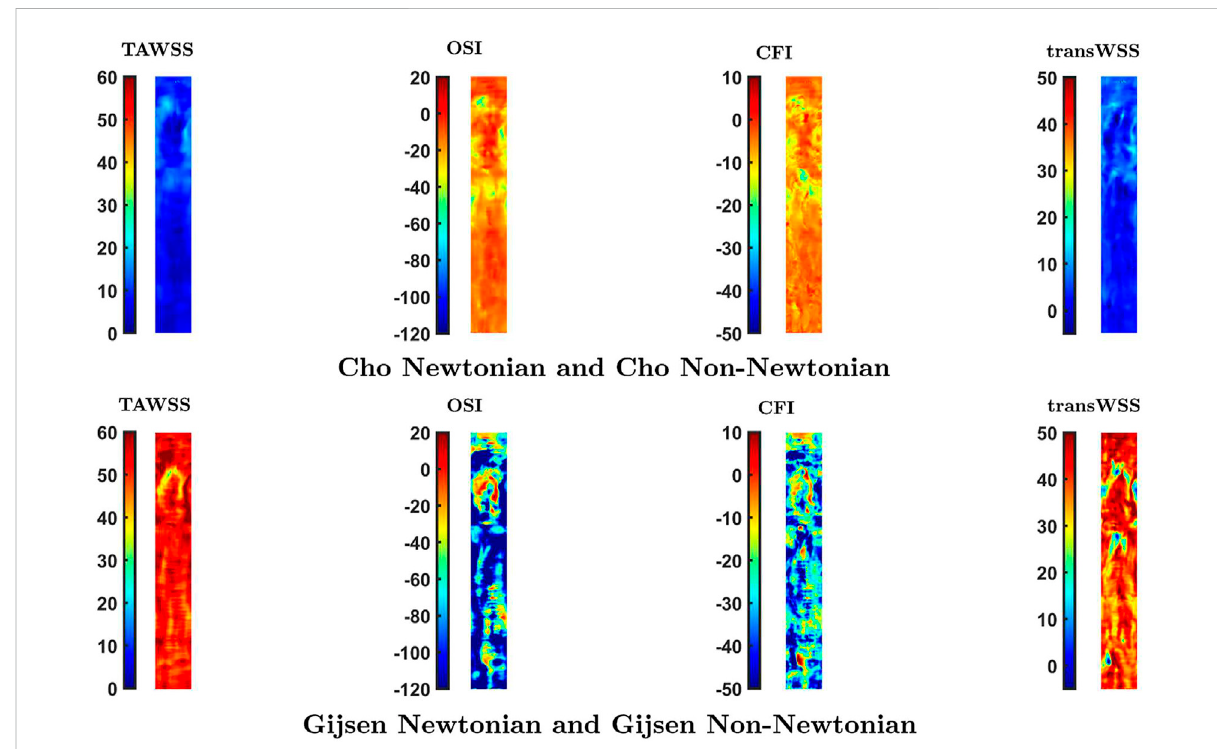
FIGURE 7 PercentagedifferenceinvaluesofthefourWSSmetricsateachlocationcausedbyaswitchfromaNewtoniantoanon-Newtonianmodel.Note that the colour scale is the same for each vertical pair of